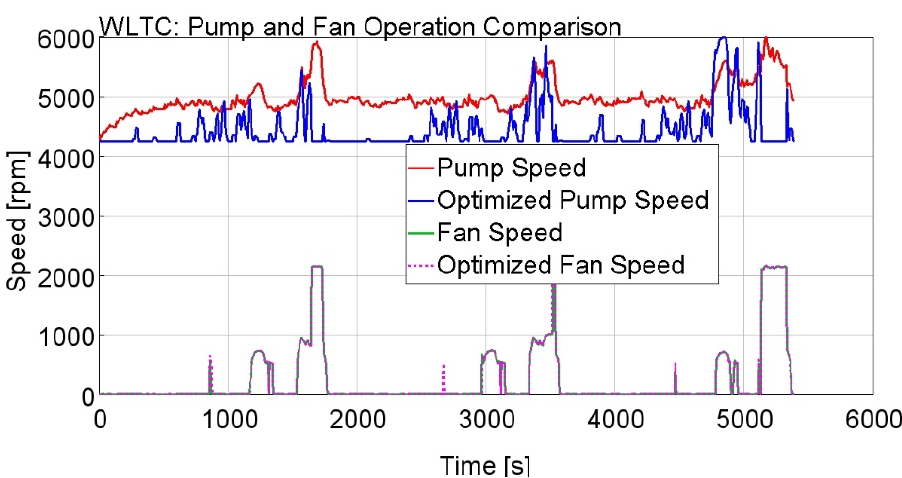
Figure 15. Control strategy comparison for single e-motor on WLTC driving cycle: coolant pump speed (top); radiator fan speed (bottom).